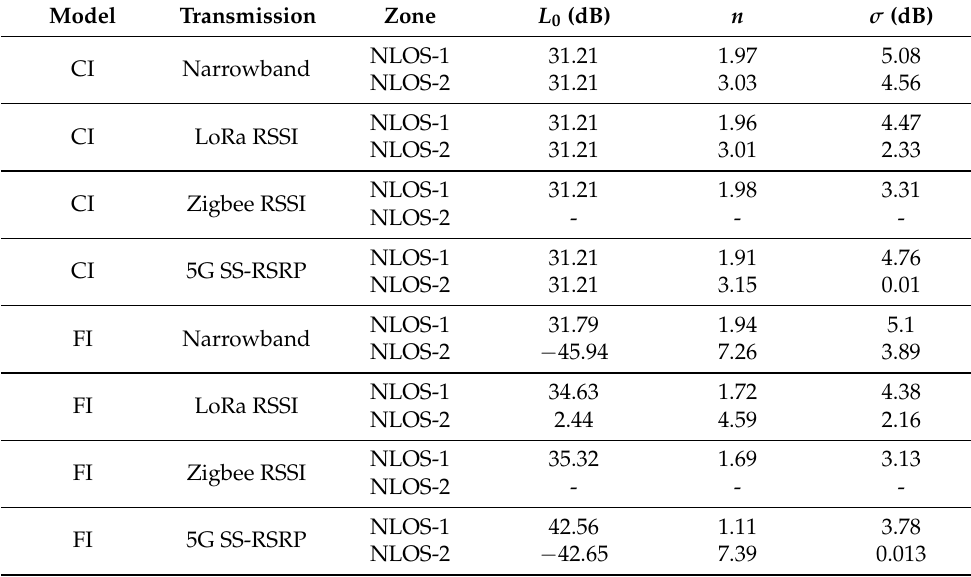
Table 3. CI and FI models’ parameters for the two scenarios at 868